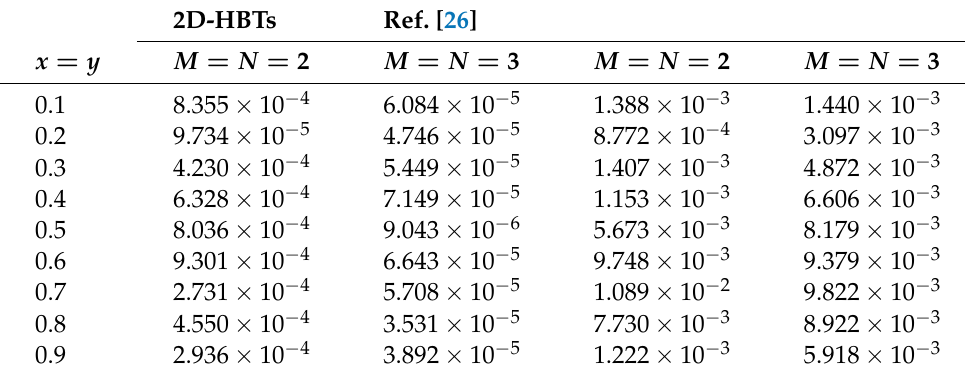
Table 4. The maximum absolute errors for λ 1 = λ 2 = 0.8 in Example 4.